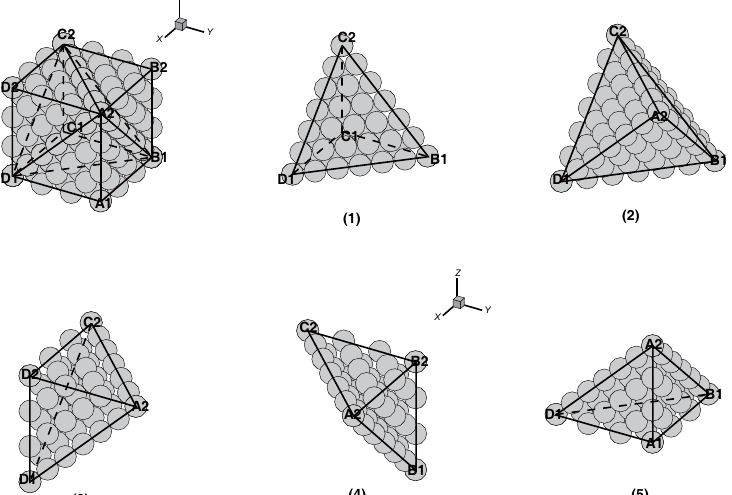
Fig. 2 Schematic diagram of dividing a cube to constitute a coarse-graining mesh in the far region of the substrate. The tetrahedral elements (1), (3), (4), and (5) are congruent and are smaller than the tetrahedral element